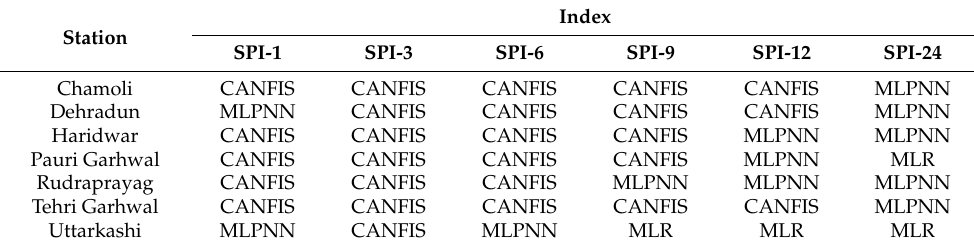
Table 7. Evaluation of AI and regression models at study